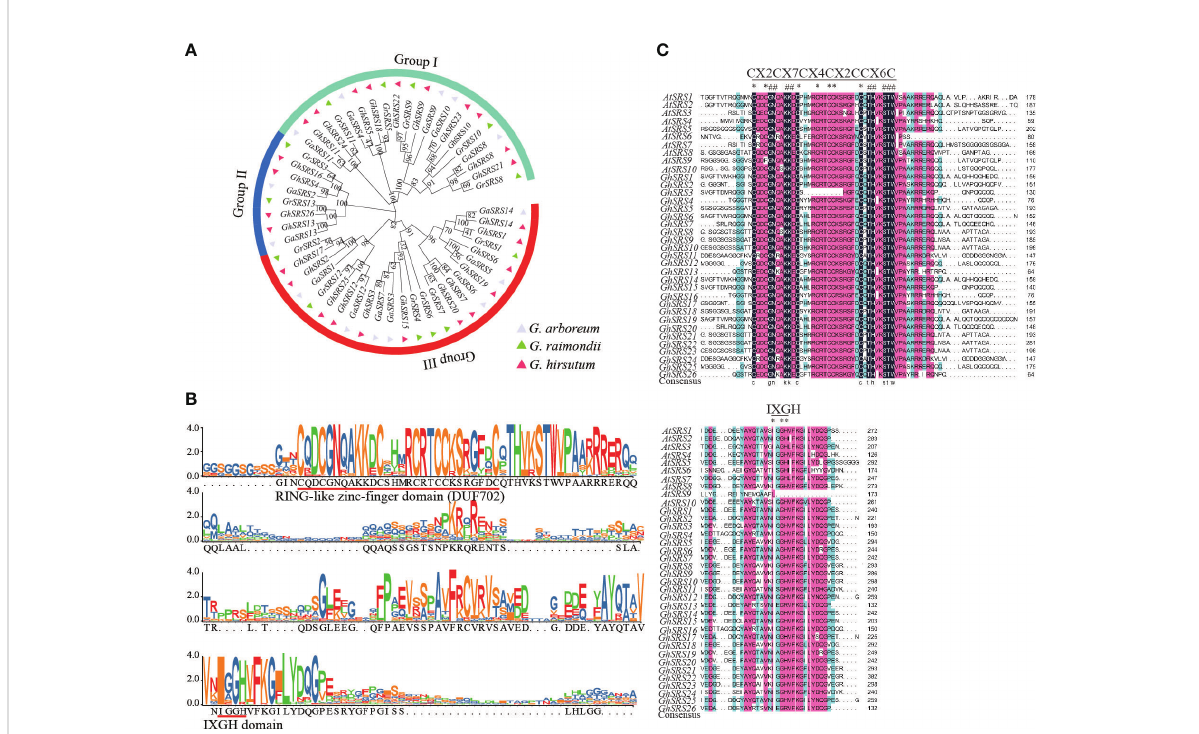
FIGURE 1 Phylogenetic and domain structure analysis of the SRS family proteins in three cotton species. (A) the unrooted phylogenetic tree of the SRS family in G arboreum , G raimondii , and G hirsutum at the amino acid sequences level using Neighbor-Joining method in MEGA X with 1000 bootstrap. The subgroup was divided according to the value on the node at the root of the evolutionary tree (the value>=80: all genes under this node belong to one subgroup; the value<80: all genes under this node can be further divided into two or more subgroups). (B)